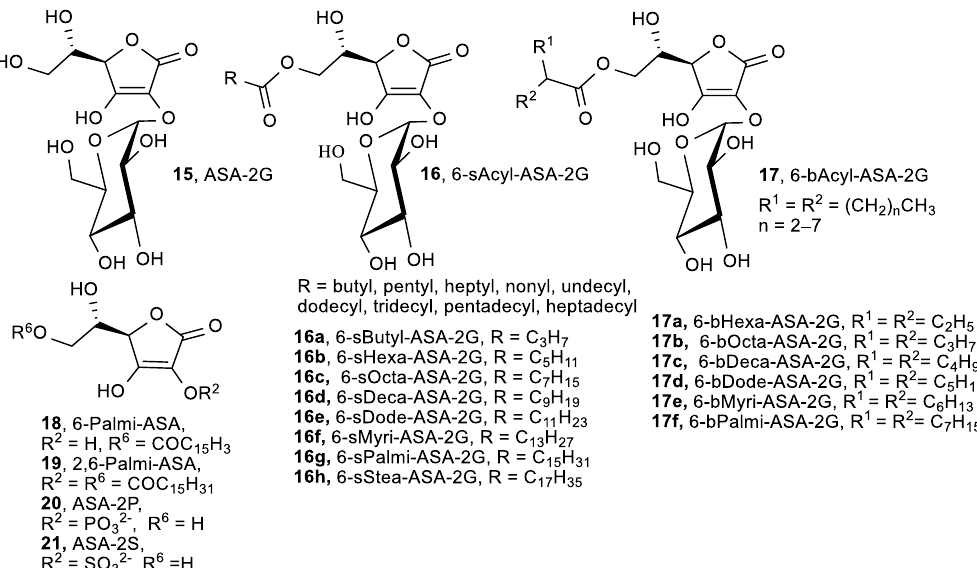
Table 4. The radical scavenging activity of glucoside ASA derivatives. Comp.